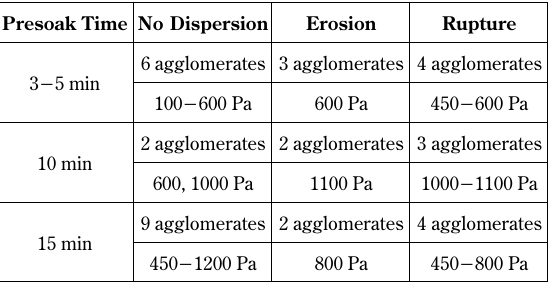
Table 1 Summary of the results of steady shear experiments with hydrophobic agglomerates. The relative frequency of the three possible dispersion outcomes are shown as a func- tion of presoak time. Also shown are the ranges of shear stress used to achieve the dispersion events.